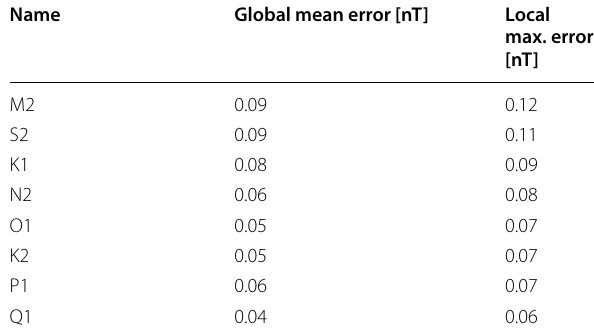
Table 2 Posterior errors from the KALMAG Kalman filter approach for the tidal constituents of Table